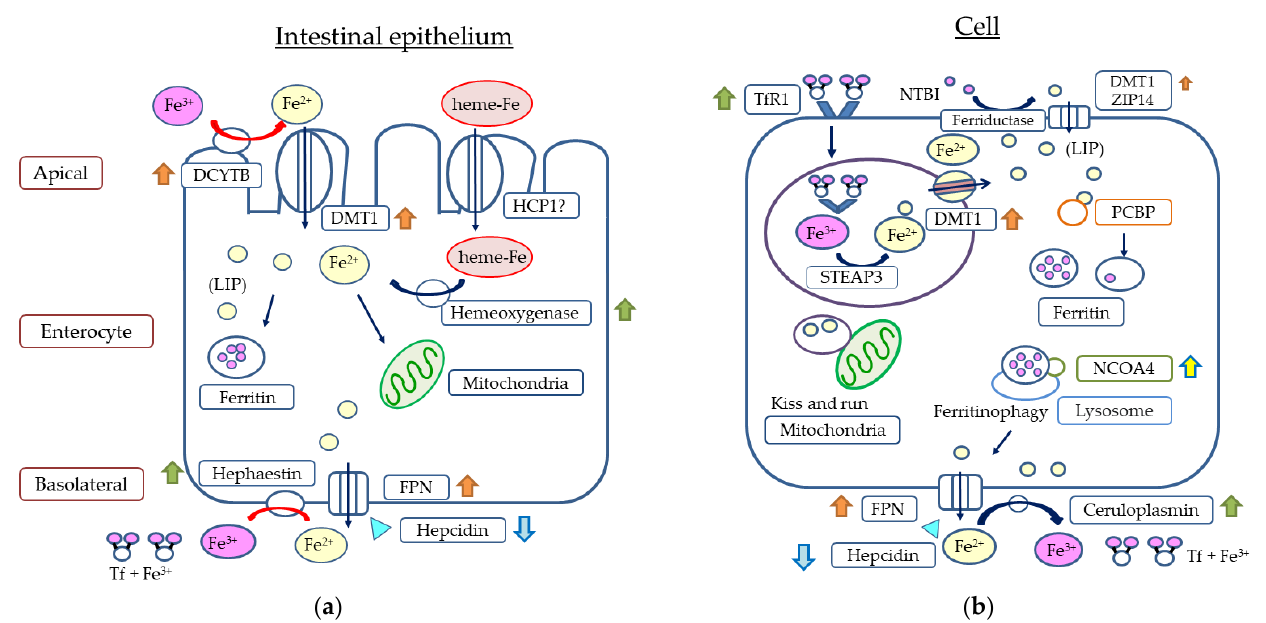
Figure 3. Intestinal epithelium ( a ) and cellular iron metabolism ( b ) . DCYTB, duodenal cytochrome B; DMT1, divalent metal transporter 1; HCP1, heme carrier protein1; FPN, ferroportin; LIP, labile iron pool; Tf, transferrin; TfR1, transferrin receptor 1